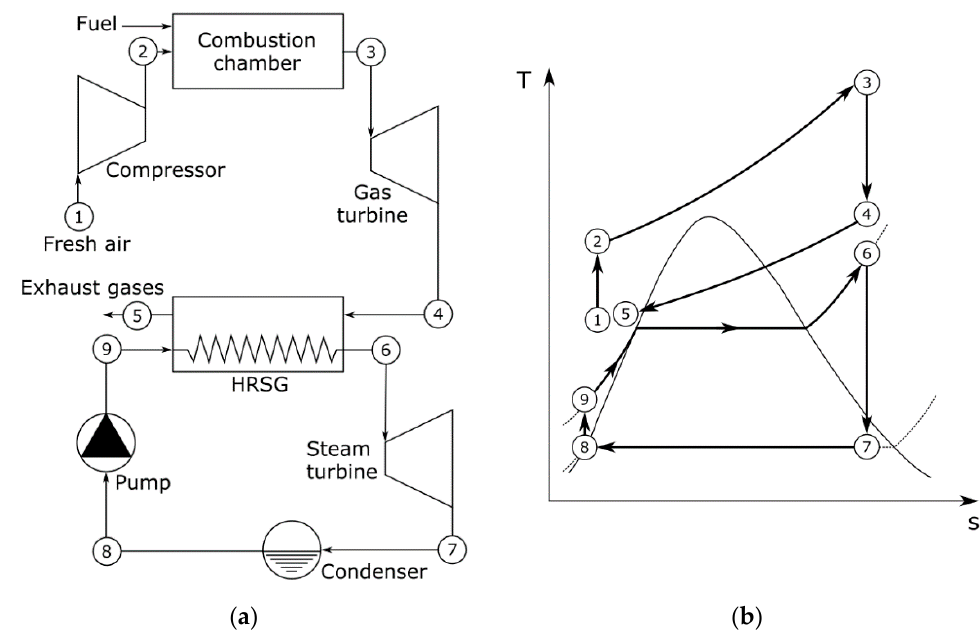
Figure 21. ( a ) Equipment and ( b ) T-s diagram of a Brayton-Rankine combined cycle).